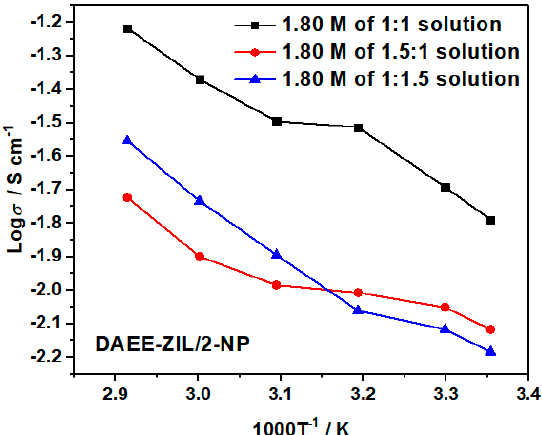
Figure12. Ionicconductivitiesof1.8MLiTFSIindi ff Figure 12. Ionic conductivities of 1.8 M LiTFSI in different weight ratios of DAEE-ZIL and 2-NP solutions.